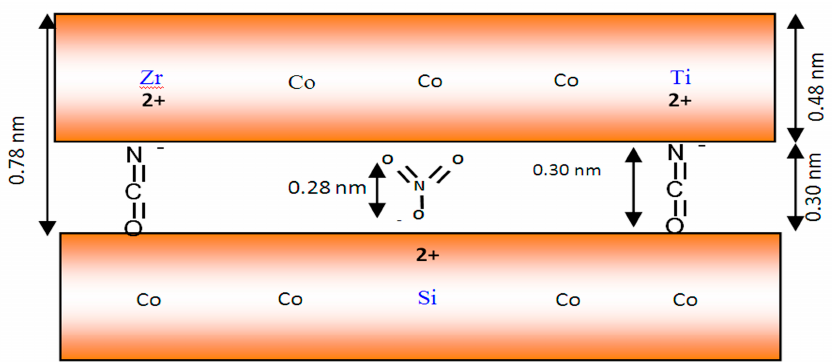
Figure 10. Schematic representation for the plates of Co–Si LDHs after zirconium and titanium inclusion.